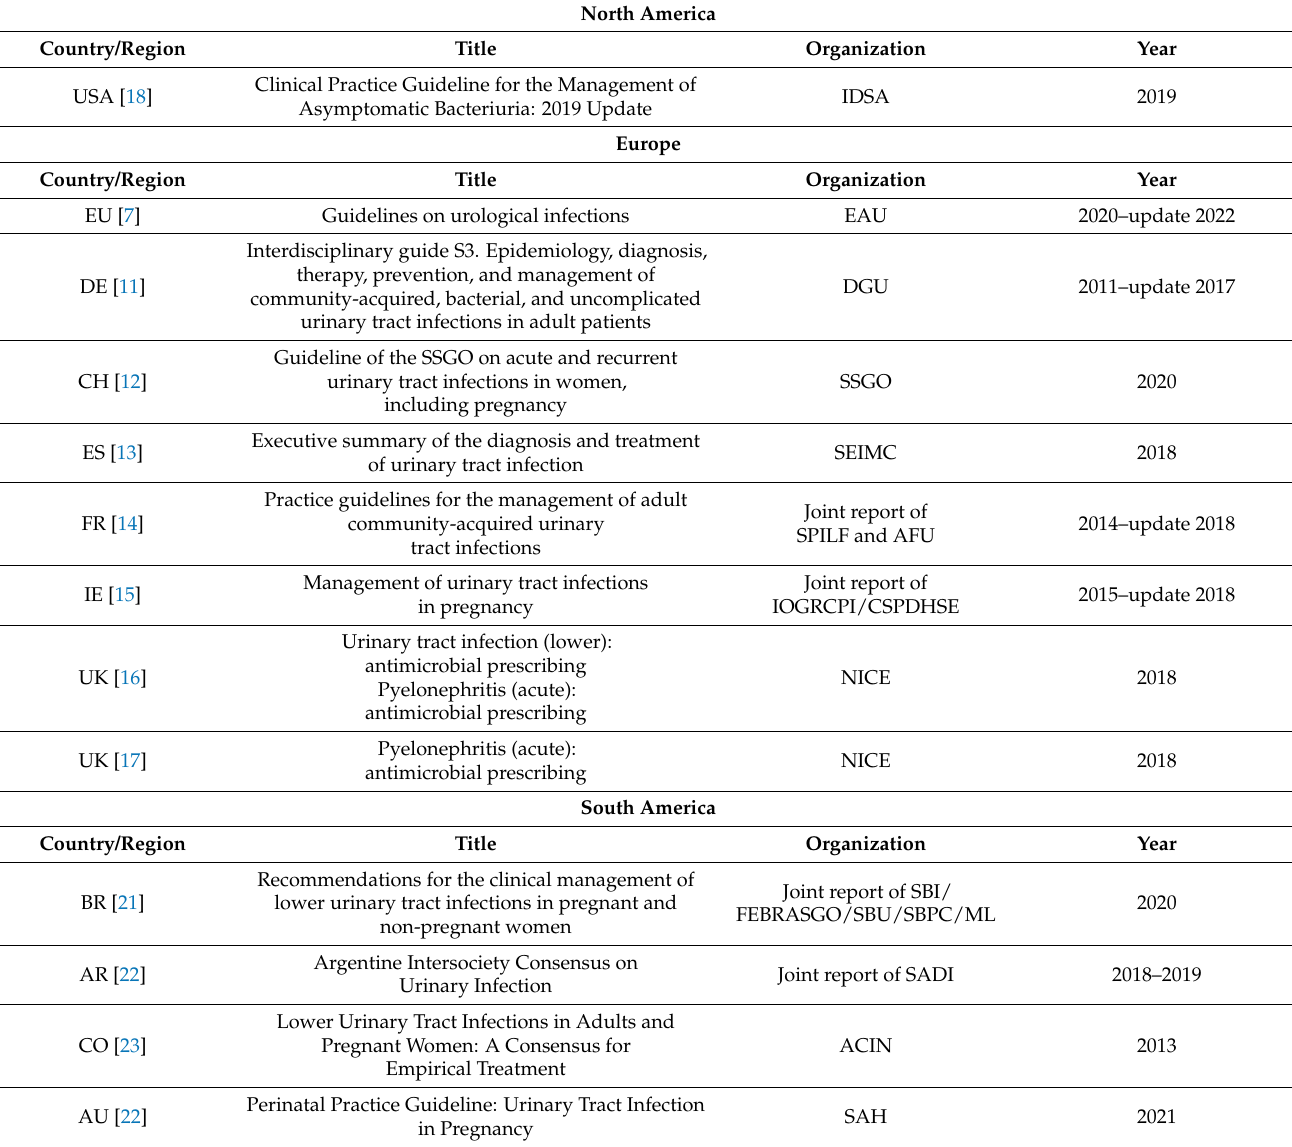
Table 1. International guidelines on urinary tract infections during